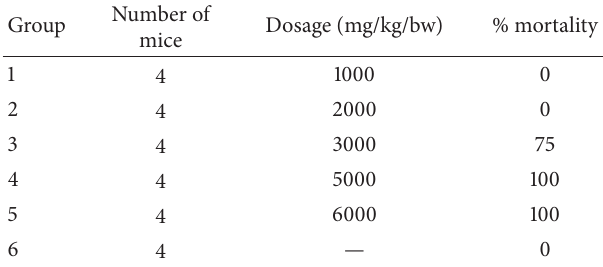
Table 1: Phytochemical composition of the ethanolic stem bark extract of A. vogelii .